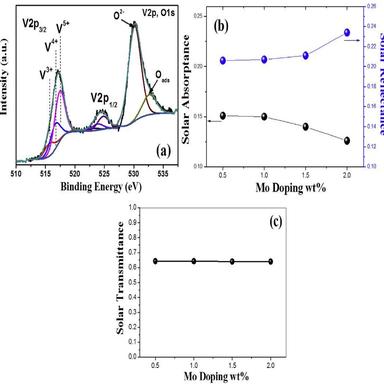
(a) The typical, illustrative, curve fitted V2p and O1s spectra of the as deposited Mo-FVO thin films on the quartz substrates with 2 wt % of Mo doping, (b) the average solar reflectance and the average solar absorptance and (c) the average solar transmittance as a function of Mo doping weight percentage in the as deposited Mo-FVO thin films on the quartz substrates.